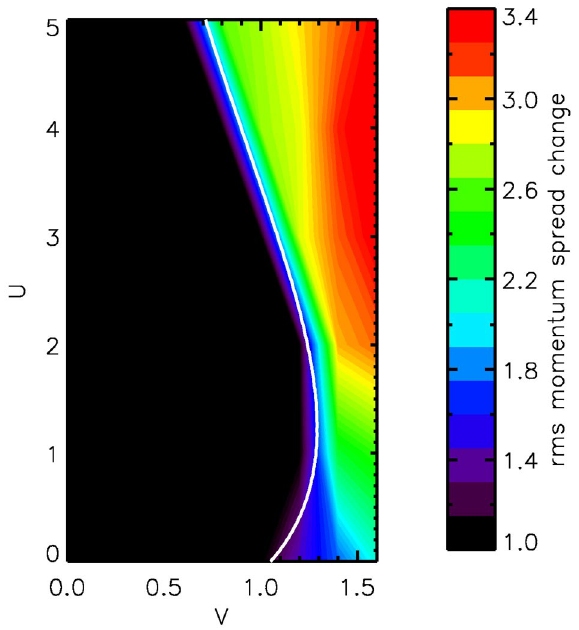
FIG. 2. (Color) Momentum spread increase in a coasting beam with a Gaussian velocity distribution as a function of initial (cid:1) U; V (cid:5) values. The black area corresponds to a stable